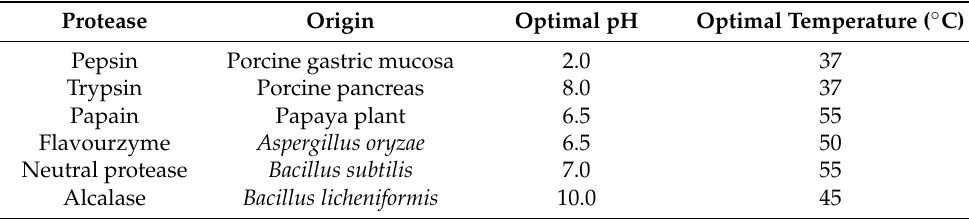
Table 2. The origin of various proteases and their enzymatic